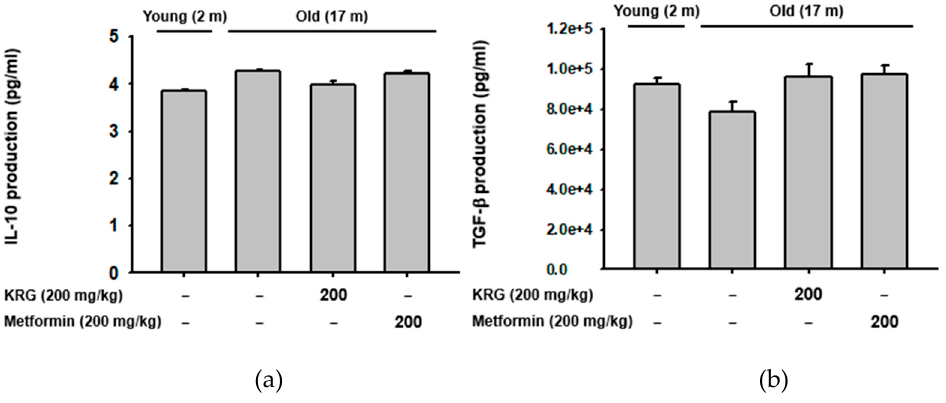
Figure 4. KRG did not alter the production of regulatory T cell-specific cytokines IL-10 and TGF- β in aged mice. Serum level of ( a ) IL-10 and ( b ) TGF- β in young and old mice dosed with KRG (200 mg/kg) or metformin (200 mg/kg) was determined using ELISA.